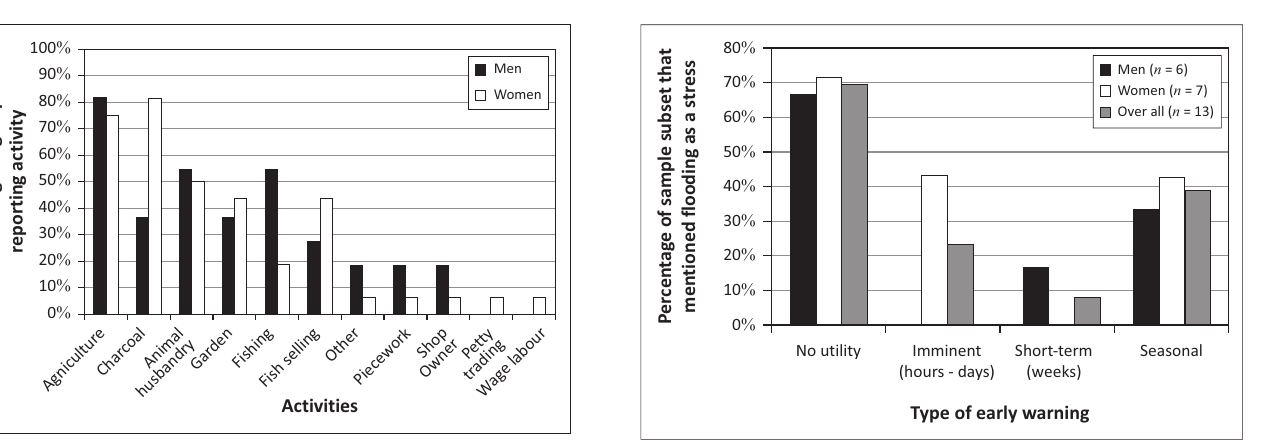
FIGURE 16: Answers of those in Group S who were asked what kinds of early warning would be useful, broken up by gender.